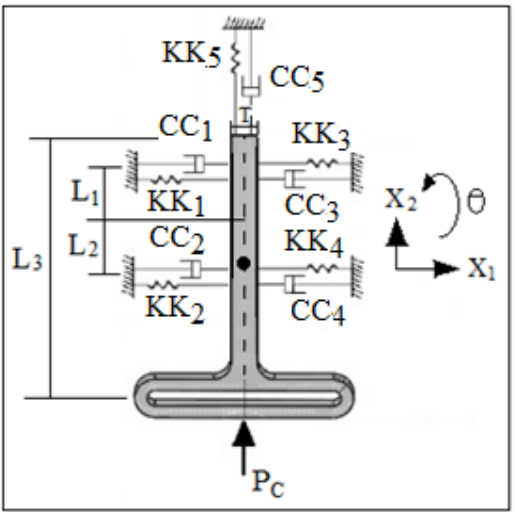
Figure 4. Three degrees of freedom of flat-faced follower.